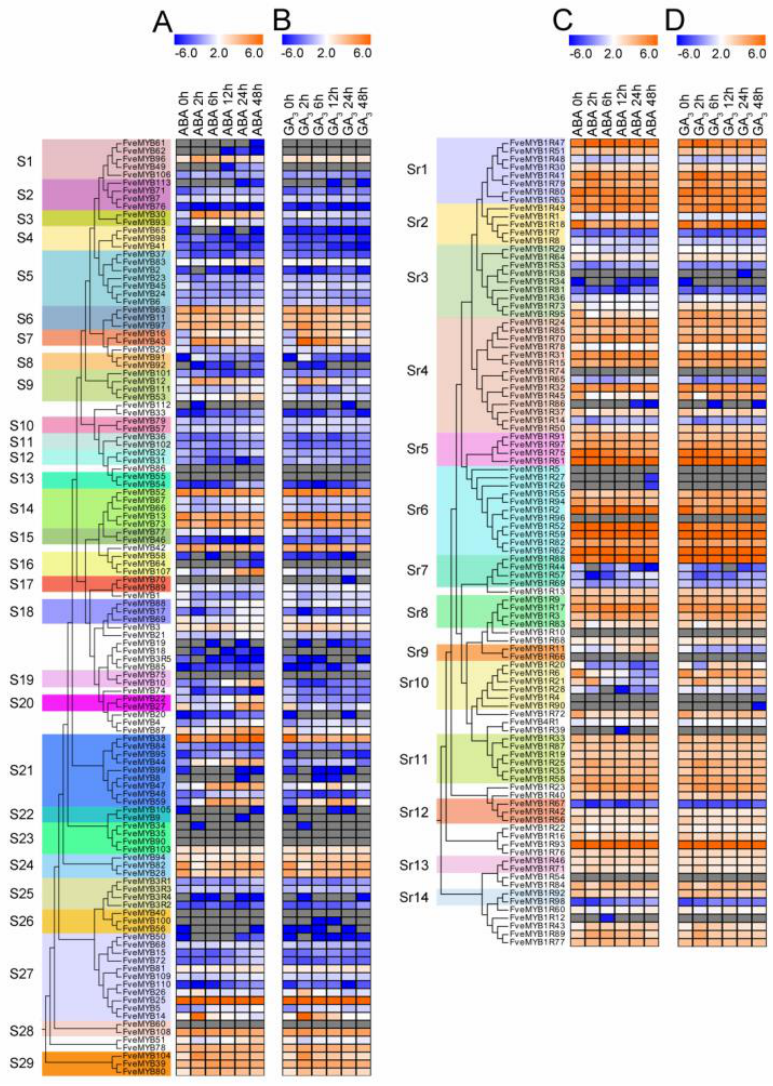
Figure 7. Expression of FveMYB genes of woodland strawberry under ABA and GA3 treatments. ( A , C ) Expressions of 2R-MYB and 3R-MYB, 1R-MYB and 4R-MYB genes of woodland strawberry under ABA treatment. ( B , D ) Expression of 2R-MYB and 3R-MYB, 1R-MYB and 4R-MYB genes of woodland strawberry under GA3 treatment. Woodland strawberry variety “Hawaii 4” seedlings were used for ABA and GA3 treatments. FPKM values were in Supplementary Table S4, and the heat map showed log2 level.